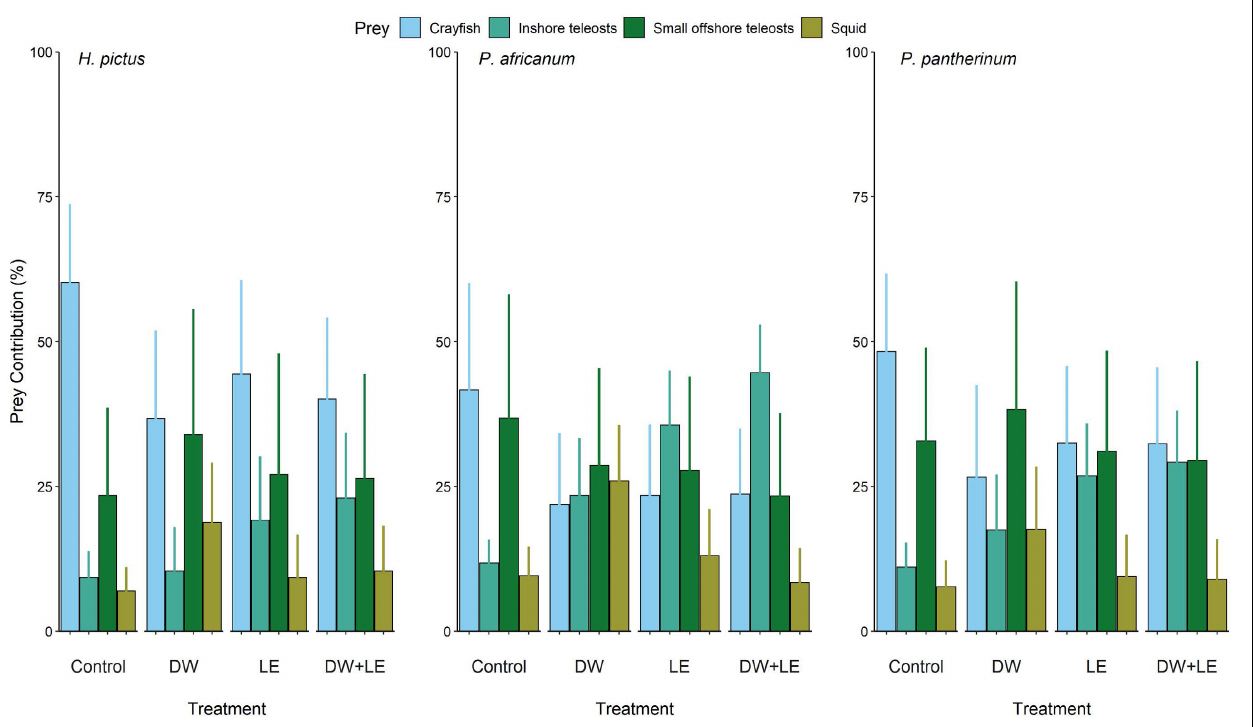
FIGURE 3 | Prey contributions to each shark species for each treatment method estimated by Bayesian stable isotope mixing models. Bars are mean ± standard deviation derived from Bayesian credibility intervals. Diet tissue discrimination factors (DTDF) are non-lipid extracted, prey specific, DTDF from nursehound Scyliorhinus stellaris (Caut et al.,